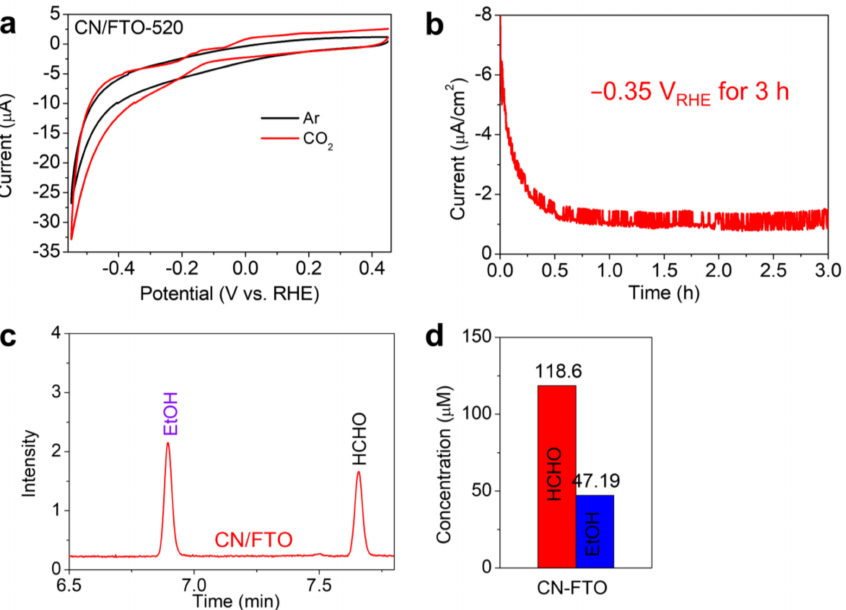
Figure 9. ( a ) Cyclic voltammograms of CN/FTO-520 using Ar-saturated and CO 2 -saturated 0.5 M KCl electrolyte. ( b ) I-t curve for CN/FTO-520 photoelectrochemical CO 2 reduction was recorded at − 0.8 V for 3 h in CO 2 -saturated 0.5 M KCl under 1 sun light illumination. ( c ) GC spectra and ( d ) the corresponding product concentration for photoelectrochemical CO 2 reduction by CN/FTO-520 films in CO 2 -saturated 0.5 M KCl solution at − 0.35 V RHE for 3